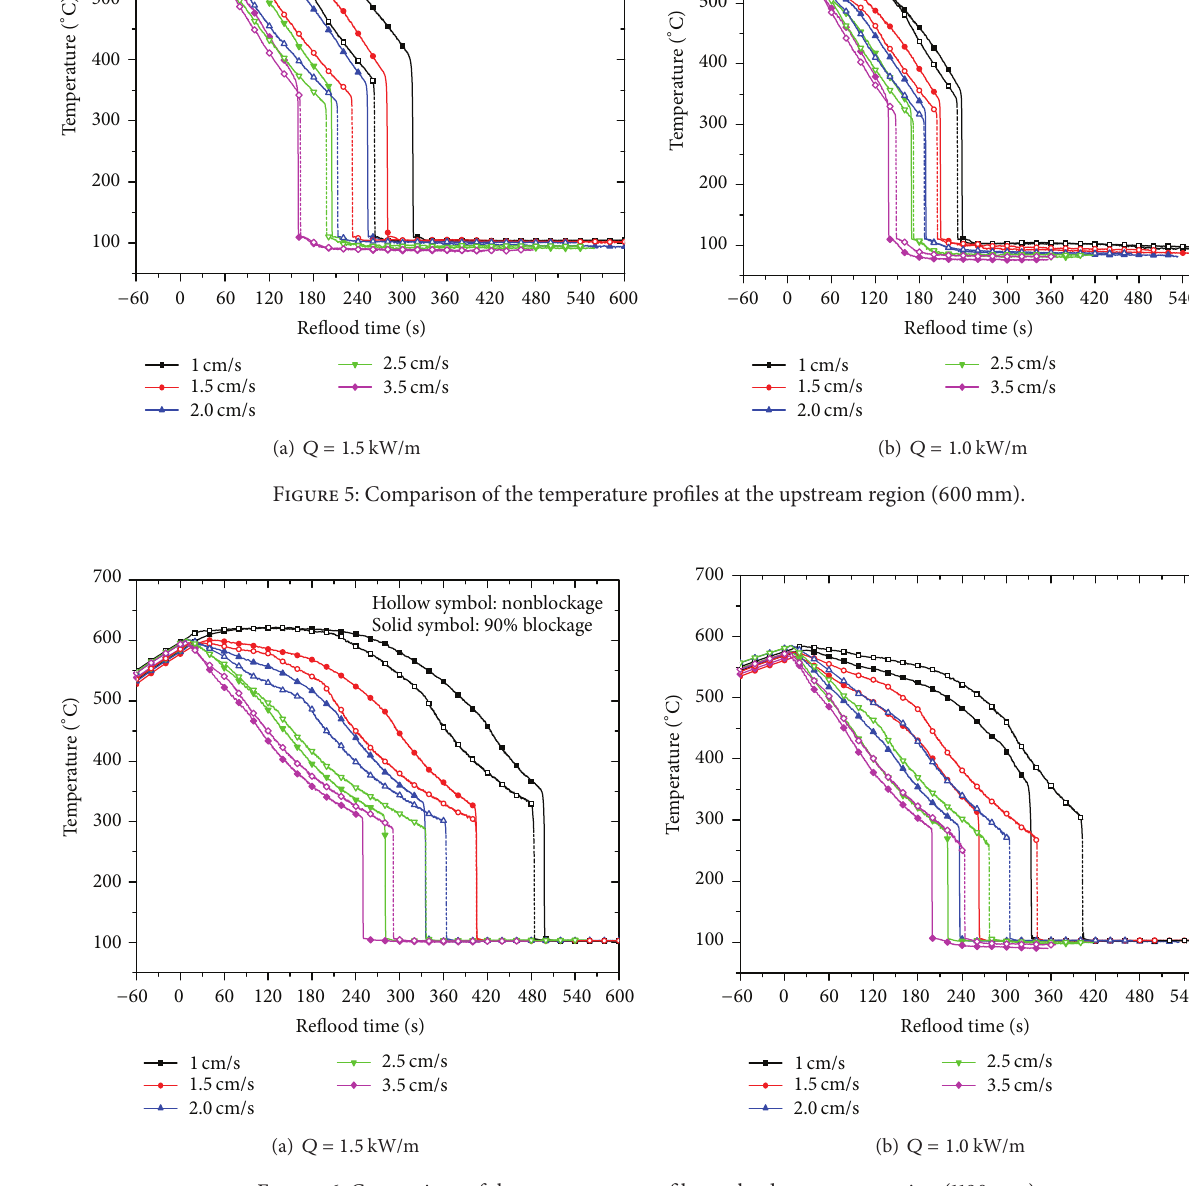
Figure 6: Comparison of the temperature profiles at the downstream region